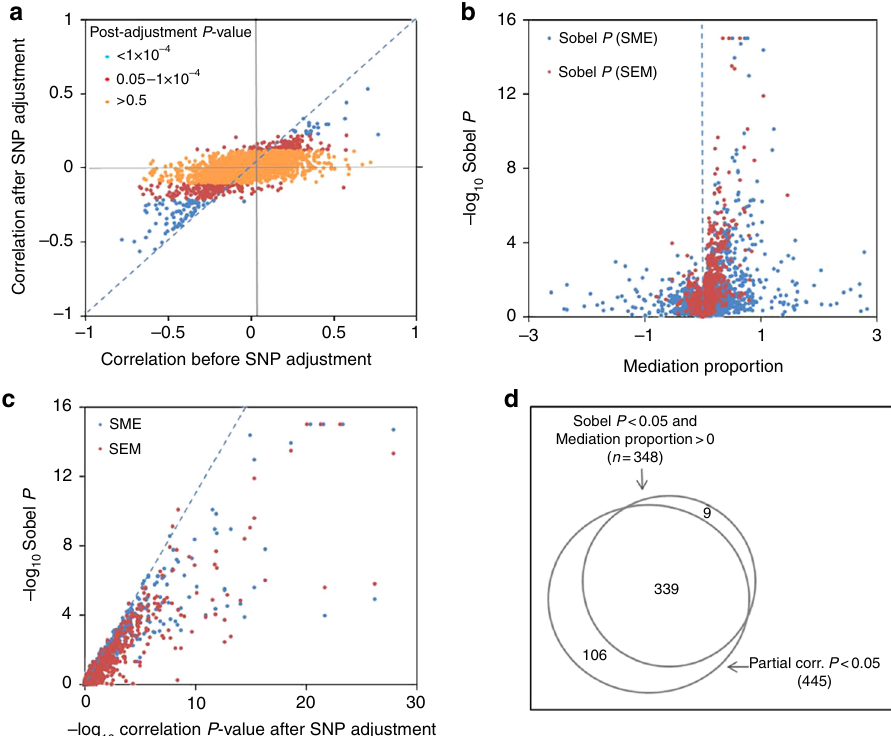
Fig. 5 Partial correlation and mediation analyses provide evidence for shared regulatory mechanisms. Results for 2913 potentially co-localized eQTL- meQTL pairs identi fi ed using a p 12 value 4.4 × 10 − 4 are presented (results for additional p 12 values are presented in Supplementary Figures 6 – 9). All models include adjustments for age, sex, and PCs from both the expression and methylation data ( n = 316). a Results from partial correlation analysis. b Mediation analysis results for both the SME (blue) and SEM (red) models. Mediation proportion outliers out of − 3 to 3 ranges were removed from the fi gure and Sobel P outliers <10 − 15 were set to the 10 − 15 . c Relationship between Sobel P from mediation analyses and the post-adjustment correlation P -values from partial correlation analysis. Sobel P outliers <10 − 15 were set to the 10 − 15 . d Venn diagram showing the concordance between mediation analysis and